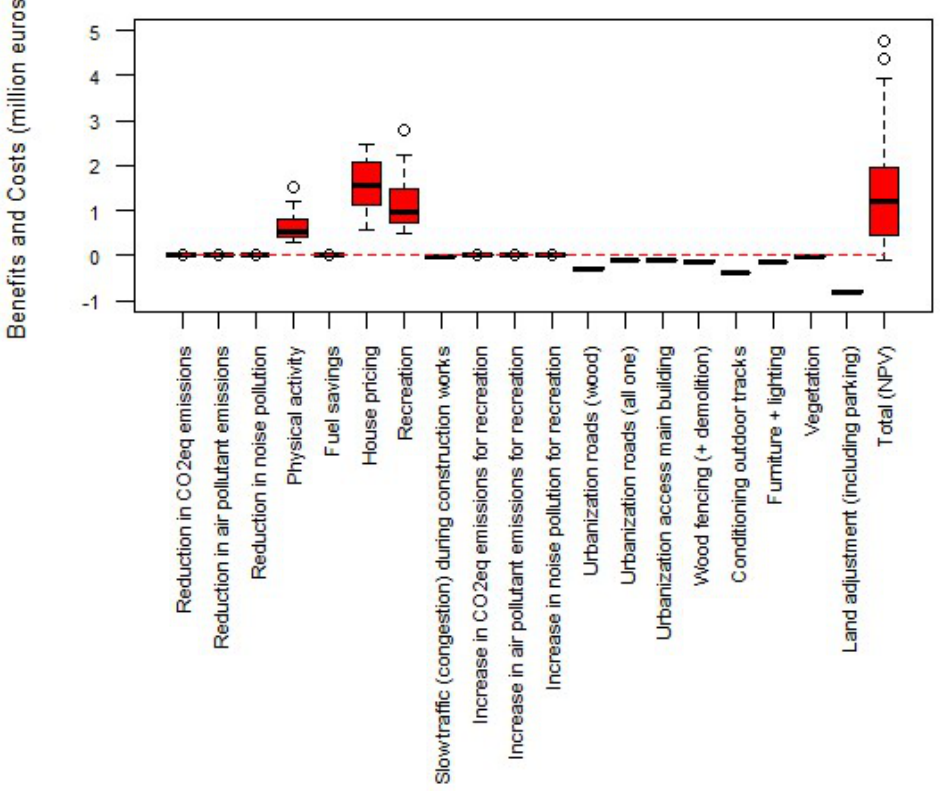
Figure 3. Distribution of the values of the benefits, costs and NPV in the different scenarios in Thinking Fadura project. The horizontal lines in the boxes indicate the median values (percentile 50) of the 54 scenarios. The box limits indicate percentile 25 and 75. The whiskers are calculated as 1.5 times the interquartile range (Q3–Q1). Circles indicate values out of the interquartile range (outliers). Red and dashed line indicates the value 0 euros.